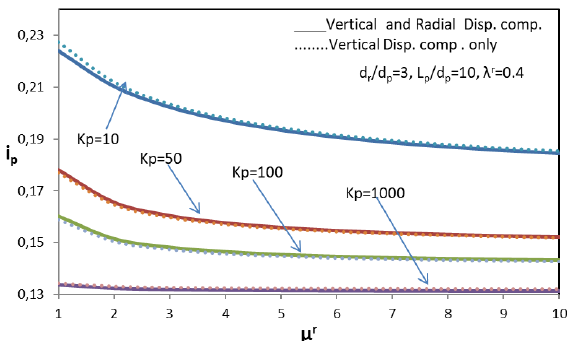
, with comparative strengthening, Figure 4: Variation of SIF, i p μ r , of GP– effect of comparative length of strengthening, K GP and radial and vertical settlement compatibility on partially